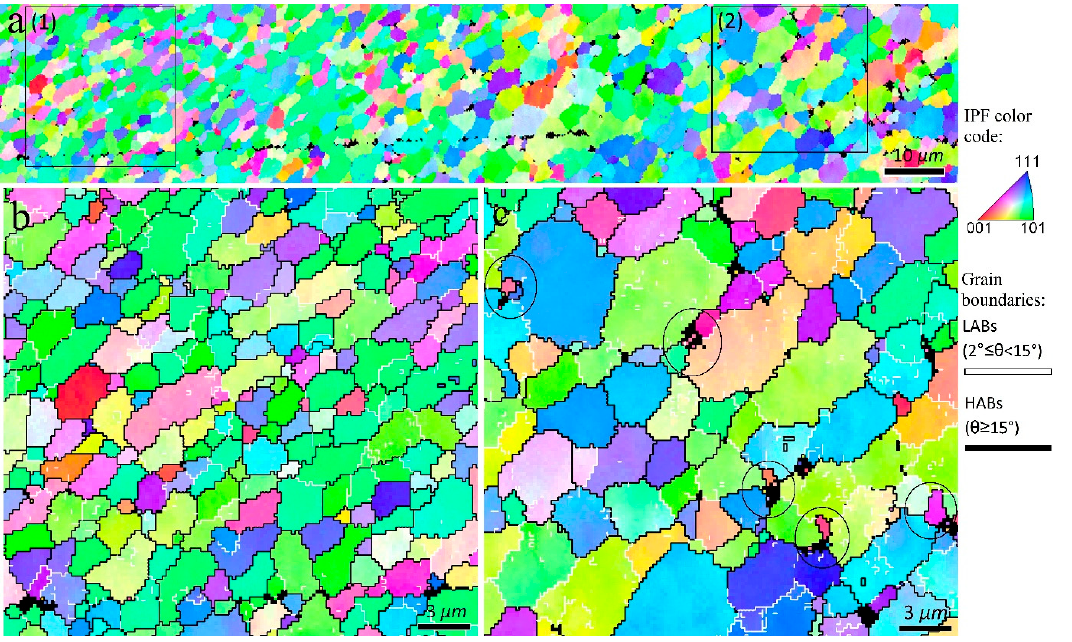
Figure 11. Inverse pole figure maps of the interfacial area between TMAZ and SZ-II in the 3-pass sample indicated by rectangle 1 in Figure 10. Higher magnification of zones 1 and 2 indicated in ( a ) are illustrated in ( b ) and ( c ), respectively. The circles in ( c ) refer to the non-index regions containing fine DRX grains, i.e., particle stimulated nucleation mechanism.